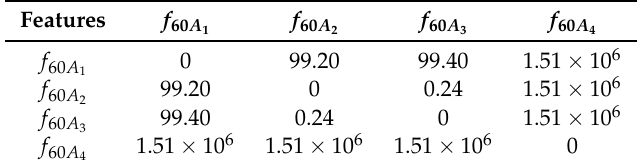
Table 4. Euclidean Distance Matrix Calculated for Selected Features (Table 2) for 60 Hz Audio ENF Signals.